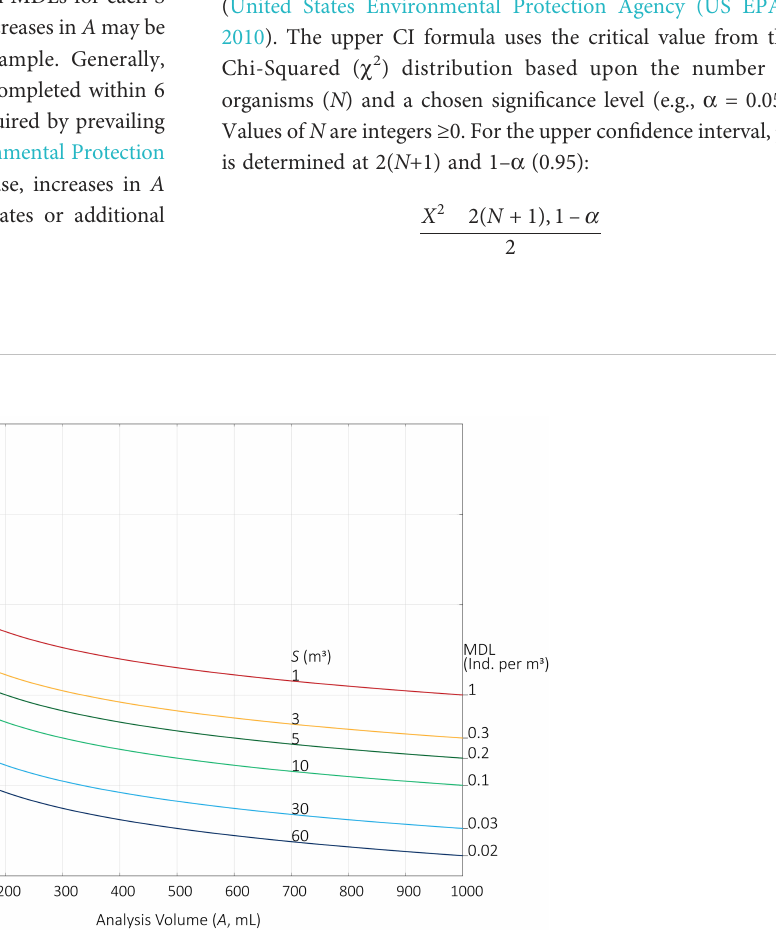
FIGURE 1 Method detection limits (MDL) for total sample volumes ( S ) of 1, 3, 5, 10, 30, and 60 m 3 . Analysis volumes (A) range from 10 to 1000 mL for a concentrated sample volume (C) of 1000 mL. Maximum MDLs (where A = C ) are listed for each S . MDLs assume 100% recovery during sample collection and handling, and 100% detection of living organisms during